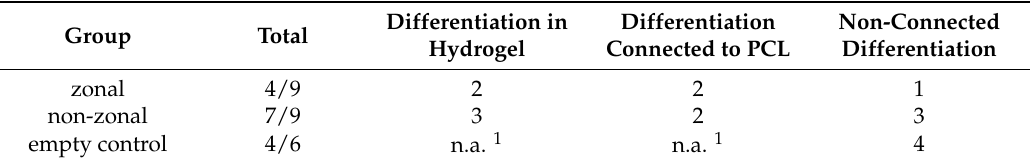
Figure 4. Hydrogel persistence in the zonal and non-zonal groups after 6 months in vivo. Overview of representative defects after treatment with zonal ( a, c ) and non-zonal ( b , d ) constructs. Black arrows: hydrogel fragments. Rectangles: area of higher magnification shown in ( c ) and ( d ). Hydrogel fragments outside of the PCL enforcement pressed into the subchondral bone indicated by dotted lines. Scale bar: 500 µm ( a , b ), 50 µm ( c , d ). Table 1. Number of defects with Safranin-O-positive regeneration tissue according to histology (Safranin O/Fast Green staining).